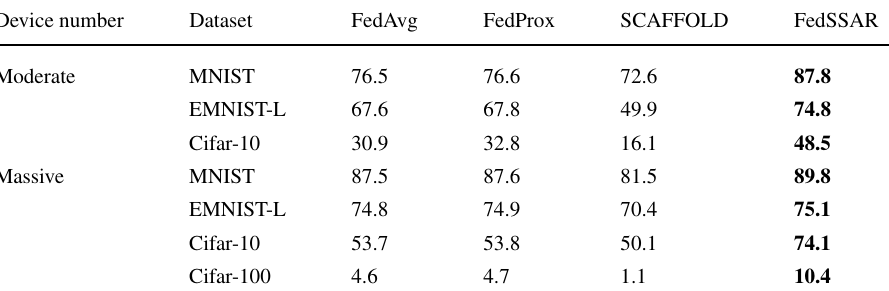
Device number Dataset